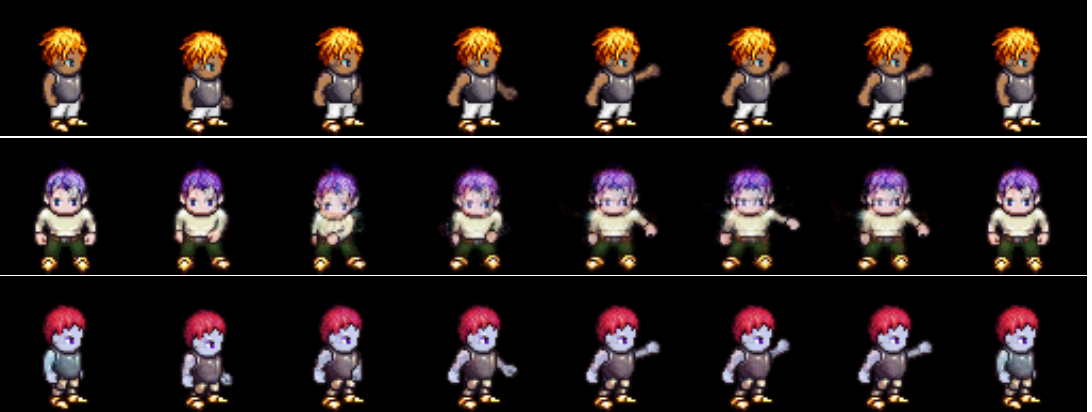
Figure 11. Example of randomly sampled generation on the Sprites dataset. We fixed the dynamic variables and randomly sampled the static variable. The top, middle, and bottom rows denote the input video and the results using DSVAE and the proposed method, respectively.